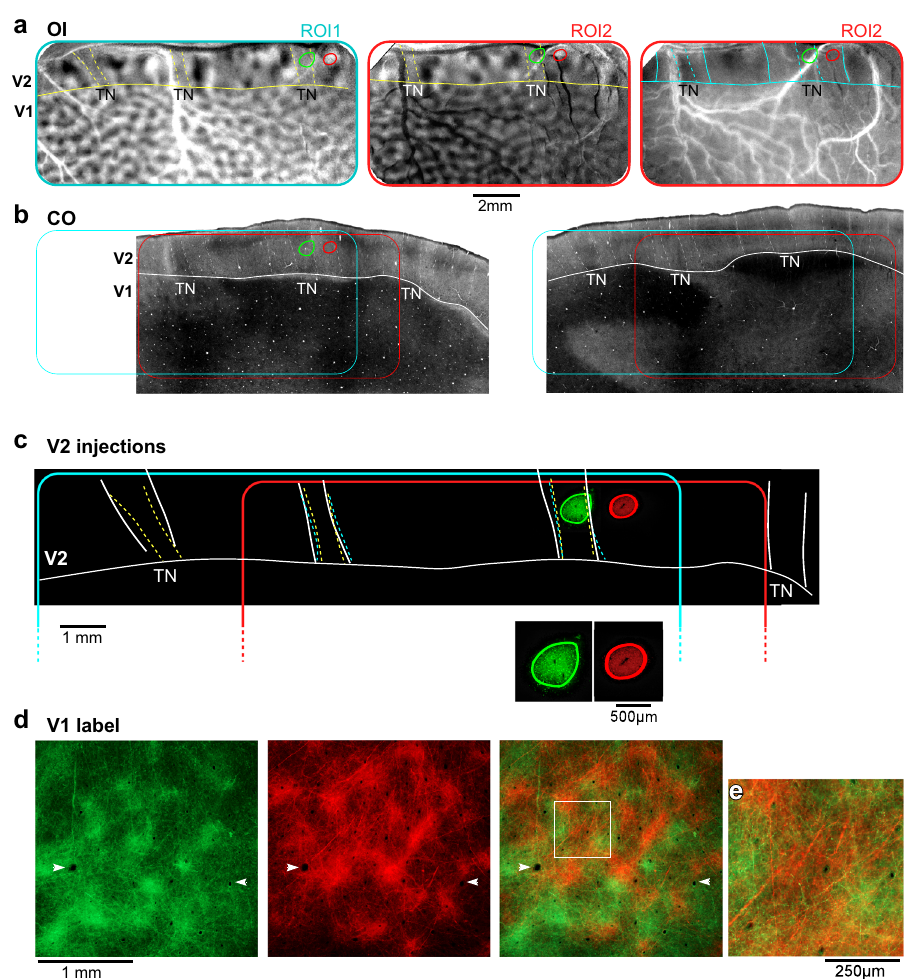
Fig. 2 Segregated V2-to-V1 feedback pathways. Case MK374RHLat. a Functional maps recorded using optical imaging (OI). Left and middle: Orientation difference map in two overlapping regions of interest (ROI1 and 2) encompassing V1 and V2, obtained by subtracting responses to achromatic gratings of two orthogonal orientations (ROI1: 45 – 135°; ROI2: 90 – 0°). Solid yellow contour: V1/V2 border based on the orientation map. Dashed yellow contours delineate the thin stripes (TN; regions of weak orientation responses). Right: SF difference map in ROI2, obtained by subtracting high-SF from low-SF responses. Horizontal solid cyan contour: V1/V2 border based on the orientation map. Vertical cyan contours delineate TN (dashed) and thick (solid) stripes, as regions having low-SF responsive domains (darker regions). b CO-stained tangential tissue sections 240 µ m apart (left one is more super fi cial), encompassing V1 and V2, revealing the stripes and the location of the two injection sites (ovals); the latter were determined by alignment of fl uorescent label to CO-stained sections (see Supplementary Fig. 1). Solid white contour: V1/V2 border based on CO staining. Dashed white contours delineate the V2 stripes. Cyan and red box: locations of optically imaged ROI1 and 2, respectively, on the CO-stained sections. Scale bar in ( a ) valid for all panels in ( a , b ). c Fluorescent micrographs of the AAV9-GFP and AAV9-tdT injection sites (shown at higher power in the inset below), outlined in green and red, respectively, with superimposed outlines of TN stripes based on CO (white) and OI maps (yellow, orientation, cyan, SF). Note the good correspondence of CO- and functionally-de fi ned stripes. The injection outlines are shown overlaid to the V2 optical maps in ( a ) and CO sections in ( b ). d Micrograph of a V1 section through L1B of V1 seen under GFP (LEFT) and tdT (MIDDLE) fl uorescence, and with the two channels merged (RIGHT). Arrowheads point to same blood vessels in all panels. GFP and tdT-labeled patches are interleaved. Label inside the white box is shown at higher power in ( e ), to demonstrate lack of labeled somata, indicating anterograde viral expression. Results in ( a – e ) are representative of six independent injections centered in thin ( n = 3) or pale ( n = 3) V2 interblobs, across all layers of FB termination. Consistent with the generate a heatmap of fl uorescent signals for that layer (Supple- laminar analysis shown above, the densest terminations were mentary Fig. 3d, Fig. 4b – f middle panels). The black circle on located in L1/upper 2 and 5B-6, and sparser projections in L2/3 each layer heatmap indicates the average blob diameter estimated and 4B. To quantify the distribution of FB projections in the from the blobs used to compute the heatmap for that speci fi c blobs and interblobs of V1, for each layer we measured fl uor- layer (as described in the “ Methods ” and in Supplementary escent signal intensity within a square region of interest (ROI) Fig. 3a, b). In all layers, the highest fl uorescence intensity lay centered on each blob overlaying the FB termination zone, and outside the average blob border, indicating the densest FB ter- encompassing the average blob and interblob diameter in the CO mination lay in the interblobs. The densest FB label, in this case, map (see “ Methods ” and Supplementary Fig. 3a, c). Fluorescent was located in the upper right quadrant of the heatmaps, rather signal intensity was, then, summed across all blob ROIs within a than uniformly fi lling the entire interblob region all around the layer, and normalized to the maximum intensity value, to blob. Indeed the densest FB label was consistently located to one